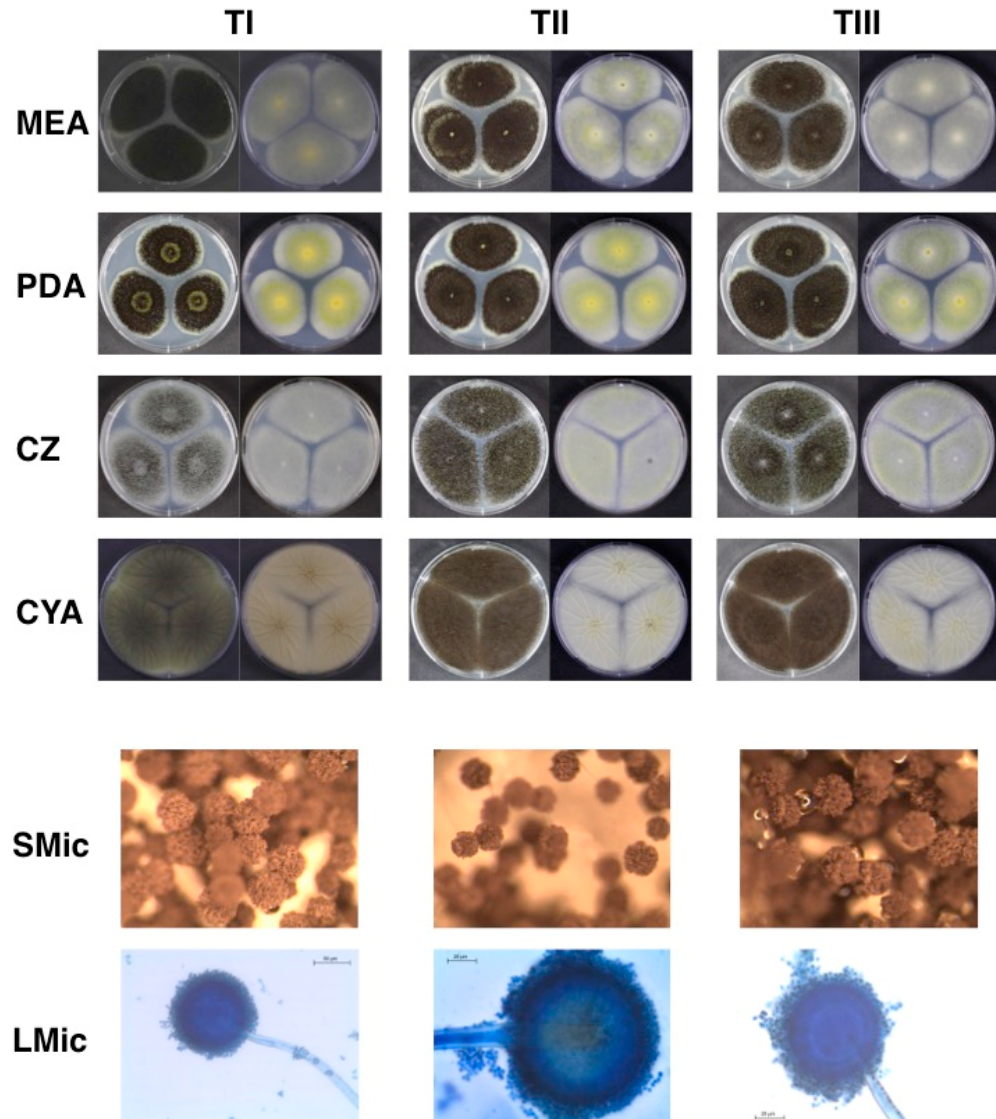
Figure 1. Morphological characteristics of Aspergillus niger Filamentous Fungal Culture Collection Micoteca da Universidade do Minho (MUM) 05.11 before (TI), after 2 weeks (TII) and 4 weeks (TIII) of freeze-drying and accelerated storage. Obverse (left) and reverse (right) of colonies grown for 7 days in the dark, at 25 °C on malt extract agar (MEA), potato dextrose agar (PDA), Czapek agar (CZ) and Czapek agar with yeast extract (CYA) media are shown. Stereomicroscope images (SMic) showing general colour and morphological characteristics of colony and light microscopy images (LMic) of conidiophores at the three different ageing times are also presented.